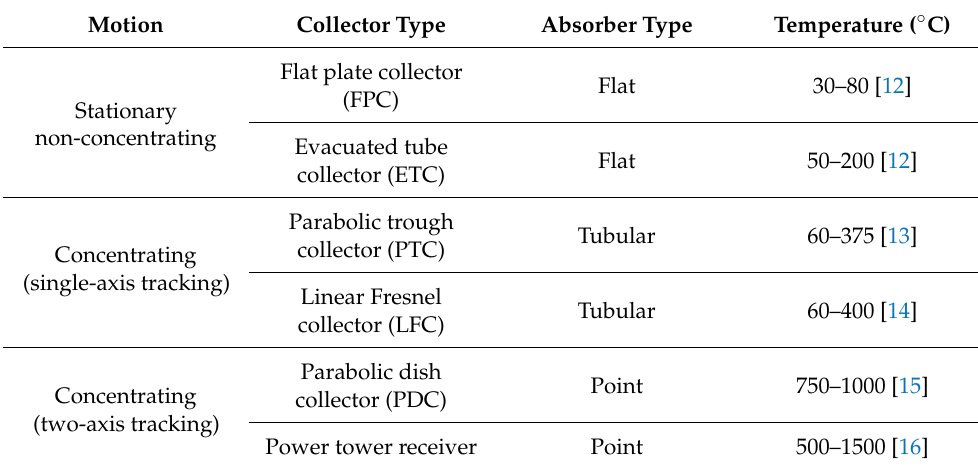
Table 2. Common types of collectors and the temperature ranges they can